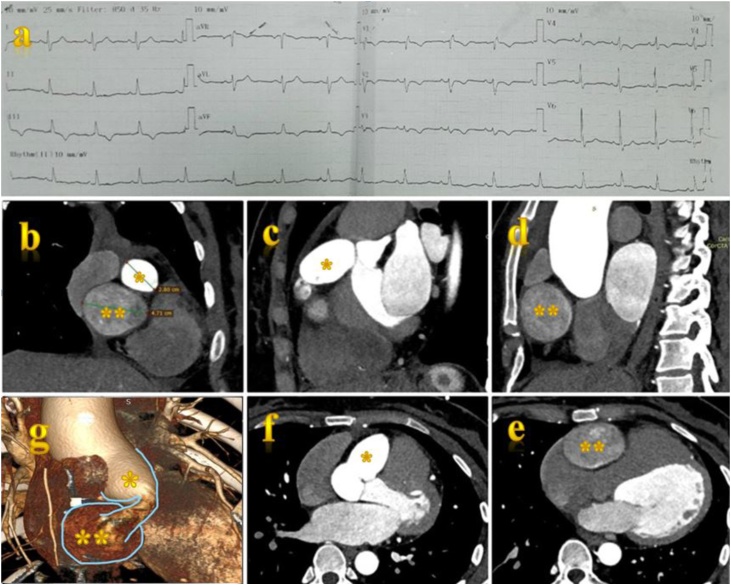
The CT scanner detected two giant aneurysmal sacs on the right coronary artery. (a) the 12-lead electrocardiogram showed sinus rhythm with a rate of 70 beats and incomplete right bundle branch block; (b) Coronal plain view of CTA; (c,d) Sagital plain view of CTA; (e,f) axial plain view of CTA; (g) three-dimension view of aneurymal sacs; (*) the first aneurymal sac; (**) the second aneurymal sac.